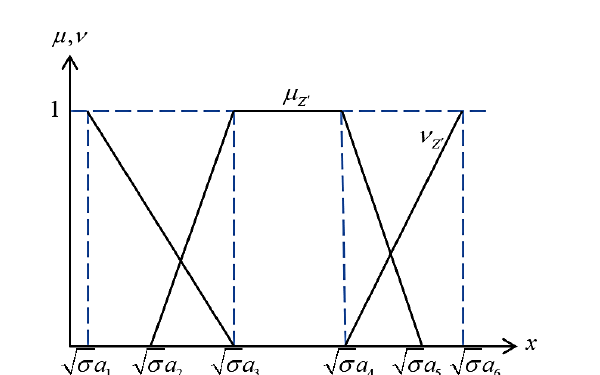
Fig. 7. The IFN converted from